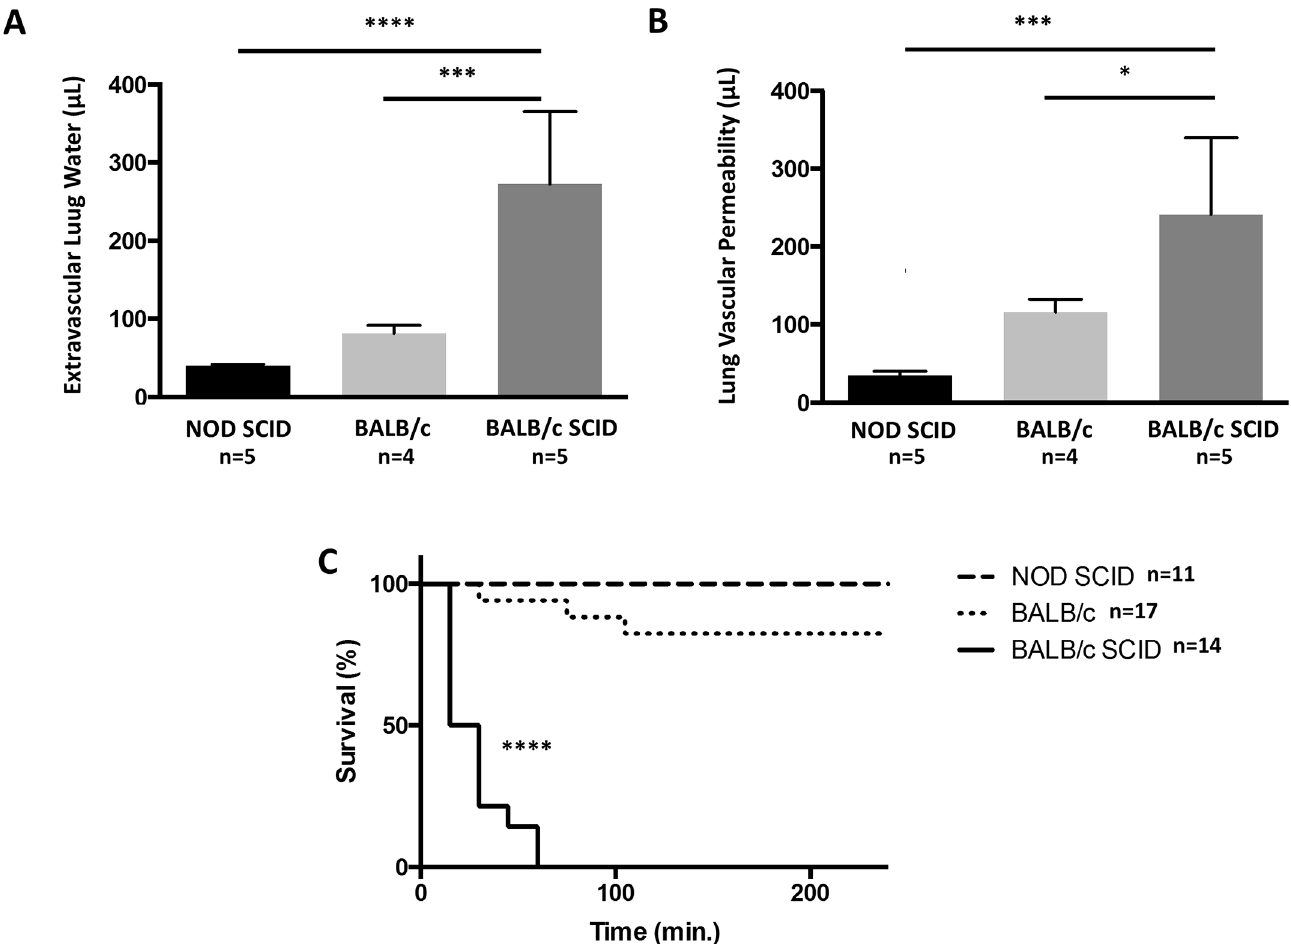
Fig 2. Lung injury and survival in mice with TRALI. LPS-primed mice challenged with MHC Class I mAb (H-2 d ) producedincreasedlung injury measuredby ( A ) extravascular lung water and ( B ) lung vascular permeability in BALB/c SCID comparedto NOD SCID mice. BALB/c wild-typemice also showedincreasedlung injury comparedto NOD SCID mice, but significantly lower than their BALB/c SCID counterparts. Mean ± SEM. n = 4–5 per group. **** p < 0.0001, *** p < 0.001, * p < 0.05(ANOVA). ( C ) BALB/c SCID (n = 14) also showeddecreasedsurvival comparedto NOD SCID (n = 11) and BALB/c wild-type(n = 17) groups. Mean ± SEM. **** p < 0.0001 vs. NOD SCID and BALB/c wild-type(Log-ranktest). PRT-treated human whole blood (pooledstorage days). Mean ± SEM. * p <